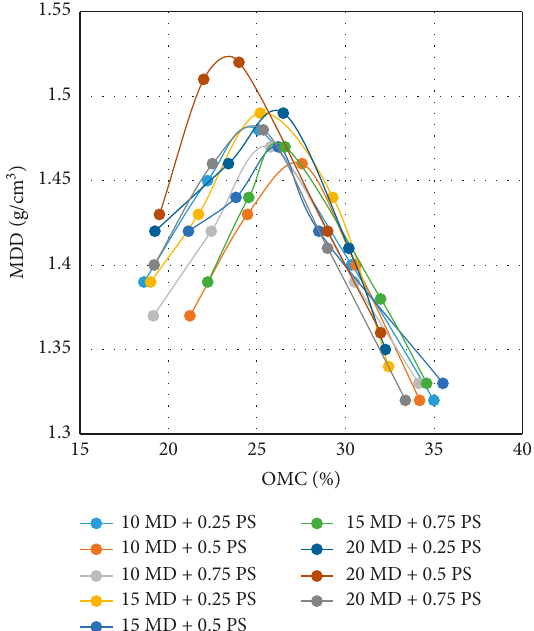
Figure 5: Variations of compaction characteristics with marble dust and plastic strip contents.